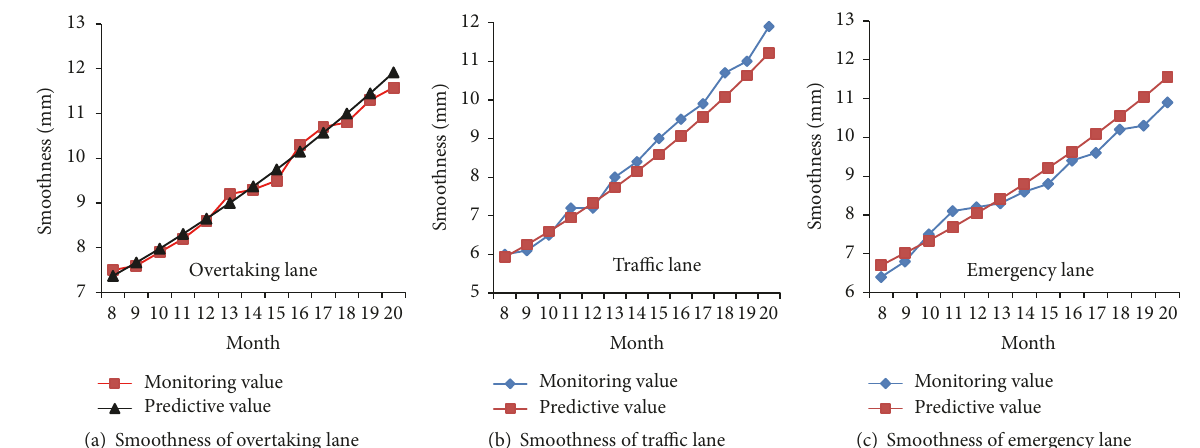
Figure 3: The change curves each lane’s smoothness.